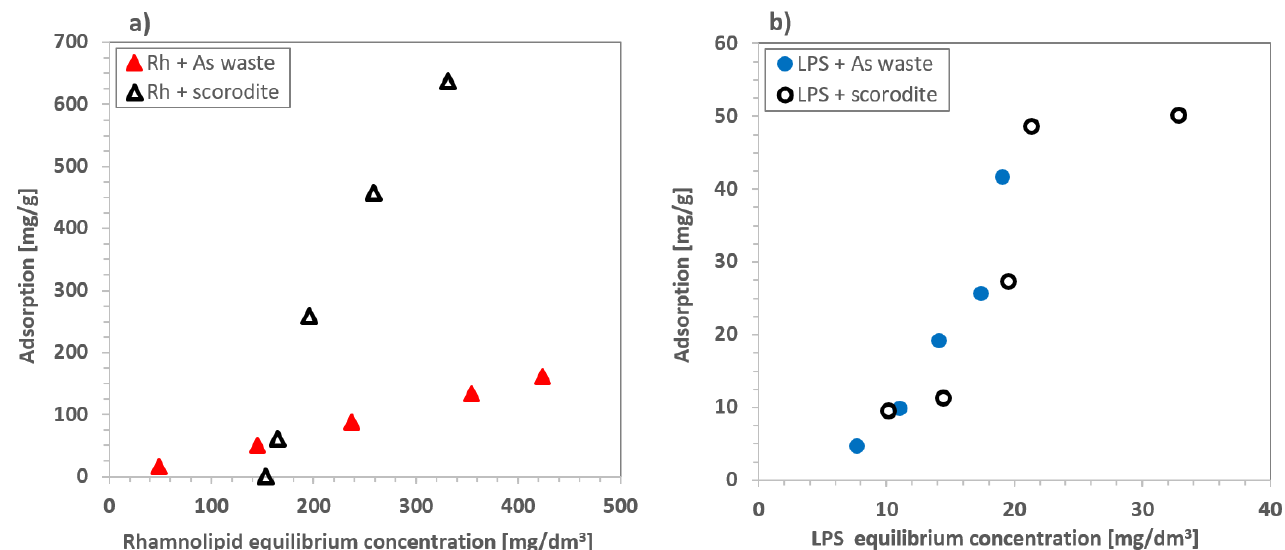
Figure 4. Adsorption isotherm of ( a ) rhamnolipids (Rh) and ( b ) lipopolysaccharides (LPS) on investigated solids.